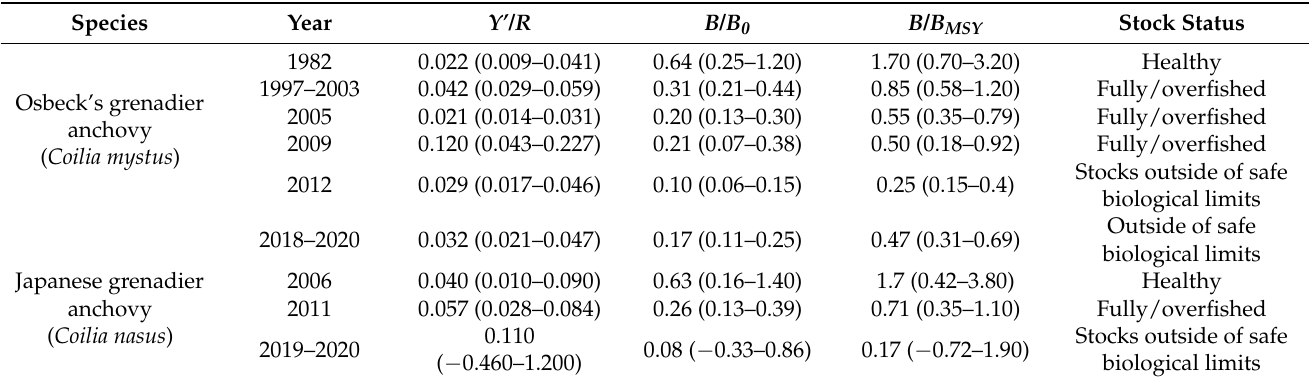
Table 2. Estimated relative biomass ( B / B 0 ) and their 95% confidence limits (in brackets) as obtained by the LBB method.